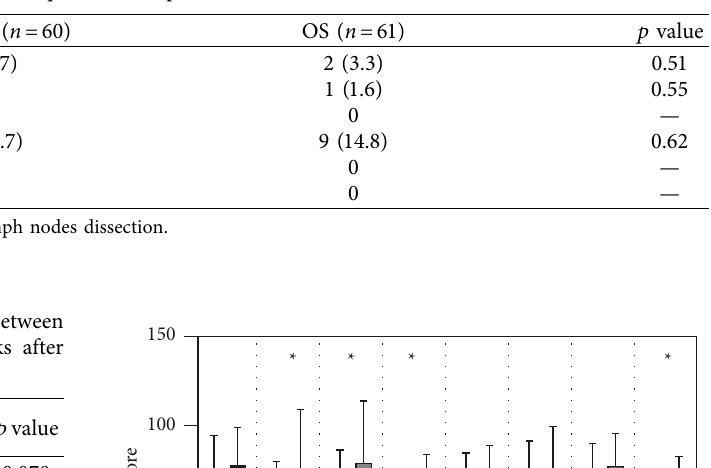
Table 3: Perioperative complications.